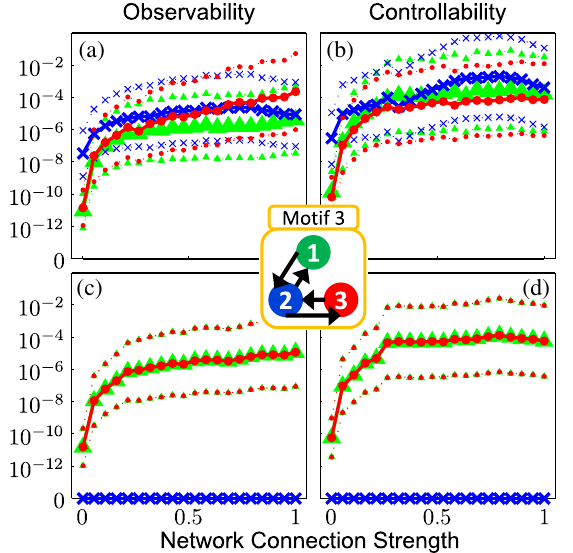
FIG. 3. Same as Fig. 2, except calculations are for motif 3. The calculations show that the reflection symmetry in the network topology causes zero observability and controllability for the symmetric case of observing or controlling from node 2 with identical coupling strengths (c),(d).